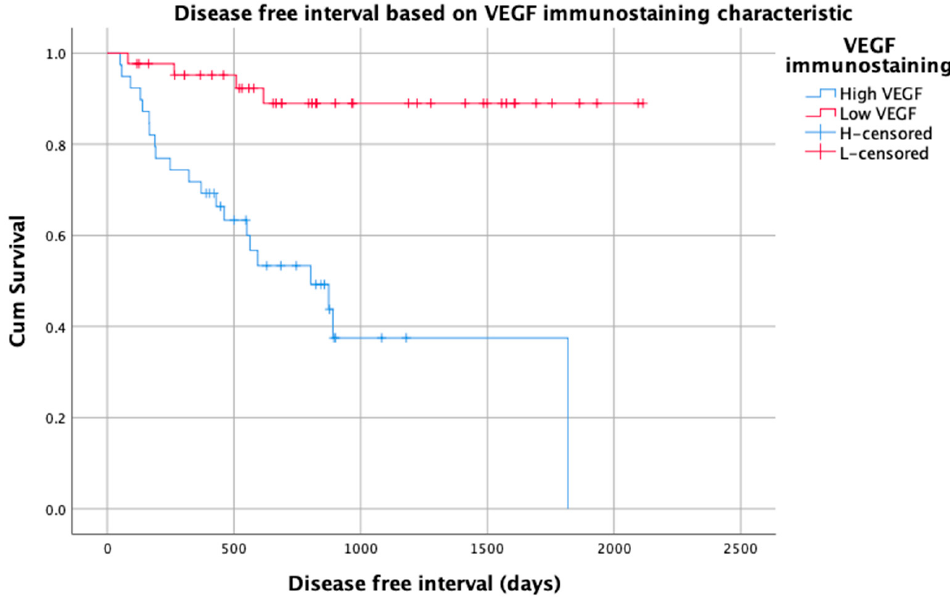
Figure 4. Kaplan–Meier graph of disease-free interval for 82 patients with soft tissue sarcoma based on VEGF immunostaining (low and high).